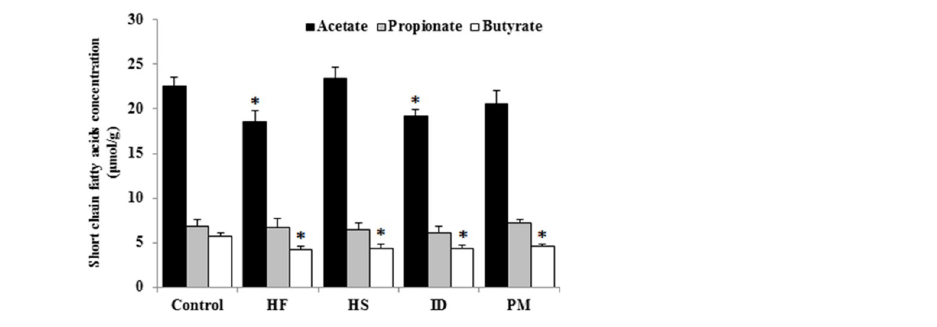
Fig 3. Concentration of short chain fatty acids in the colonic digesta according to dietary treatments. HF, high fat; HS, high sucrose; ID, iron deficiency; PM, processed meat. Values are expressed as mean ± SEM. Statistical significance compared to control was accepted at � P <